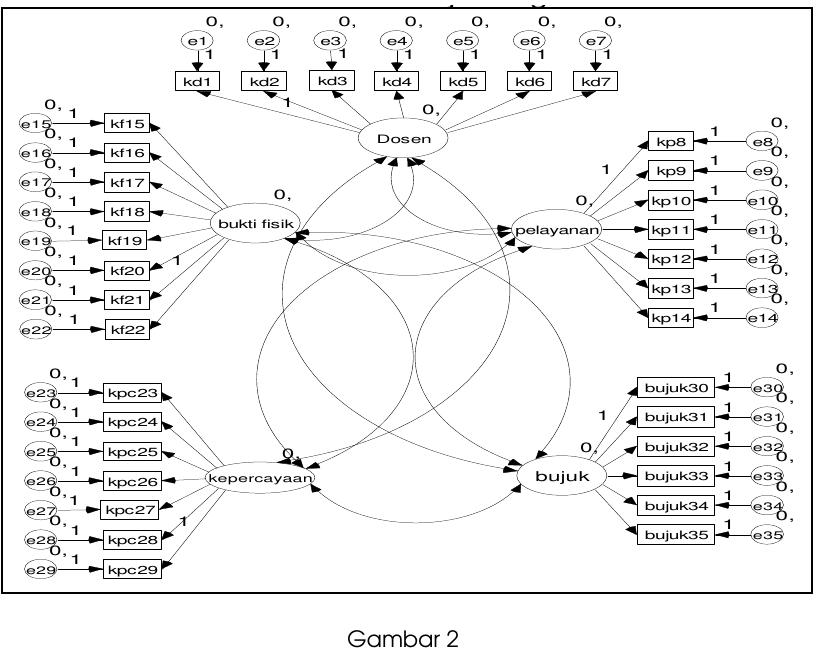
Gambar 2 Model Uji